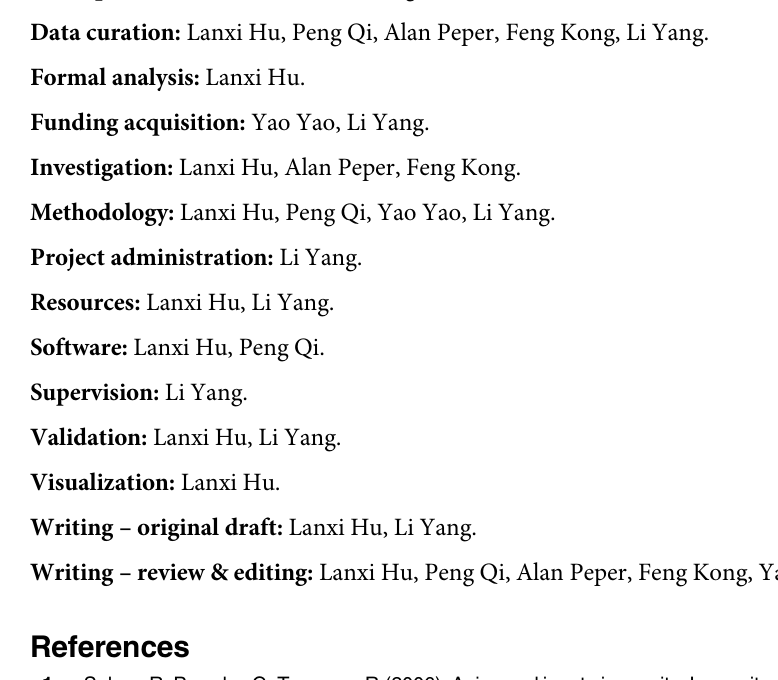
S1 Table. Seeds and primers. S2 Table. Replicates in Figs 1, 2, 5 and 7. S3 Table. Lists of Adu DEGs. S4 Table. Lists of Juv DEGs. S5 Table. Lists of r10 DEGs. S6 Table. Lists of Gene Ontology terms in Figs 3 and